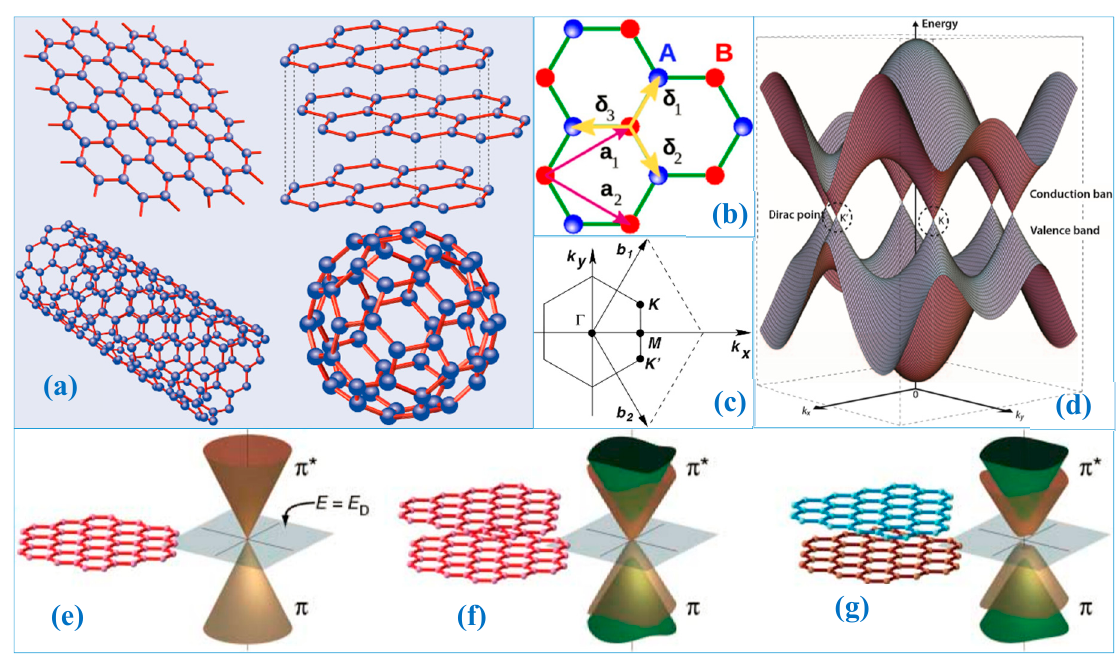
Figure 1. ( a ) Carbon-based nanomaterials [2]. Copyright 2008, Springer. ( b ) The planar crystal structure of graphene: a 1 and a 2 are the lattice vectors of the unit cell; δ 1 , δ 2 , and δ 3 are vectors mutually adjacent to each other [3]. ( c ) The Brillouin zone (BZ) corresponding to the graphene lattice (b 1 and b 2 are the reciprocal space bases; K, M, K’, etc. represent k-space high symmetry points. The coordinate axis is the k-space basis vector.) [3]. Copyright 2009, American Physical Society. ( d ) Energy band diagram of graphene’s hexagonal lattice [4]. Copyright 2009, Springer. Electronic structure of a single layer ( e ), symmetric double layer ( f ), and asymmetric double layer ( g ) of graphene. The energy bands depend only on in-plane momentum because the electrons are restricted to motion in a two-dimensional plane. The Dirac crossing points (marked by a grey cross and square) are at energy E D [5]. Copyright 2006, Science.